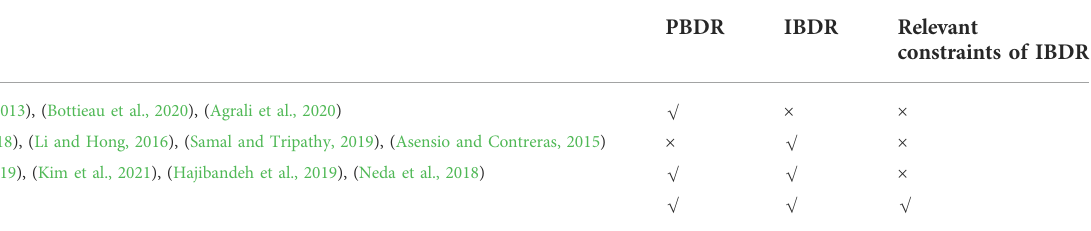
TABLE 1 Summary of previous studies considering DR.